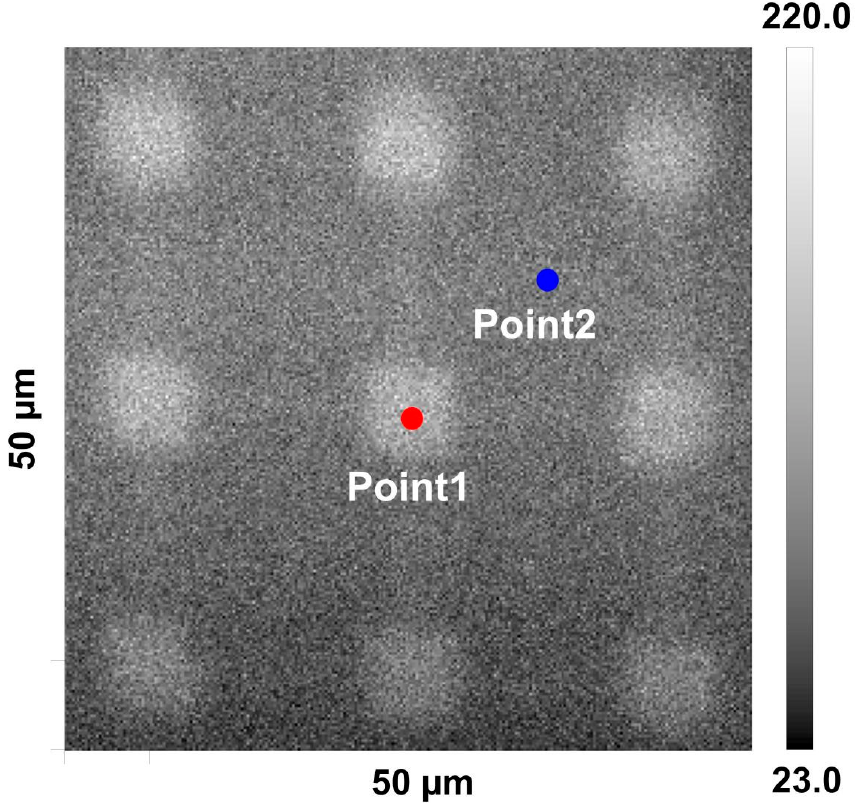
Figure 4. Induced secondary electron image (SXI) of an area of 50 µm by 50 µm. Two points are selected for further analysis. Point 1 is on one silicon dioxide pattern, and Point 2 is on one FDTS SAM film pattern.